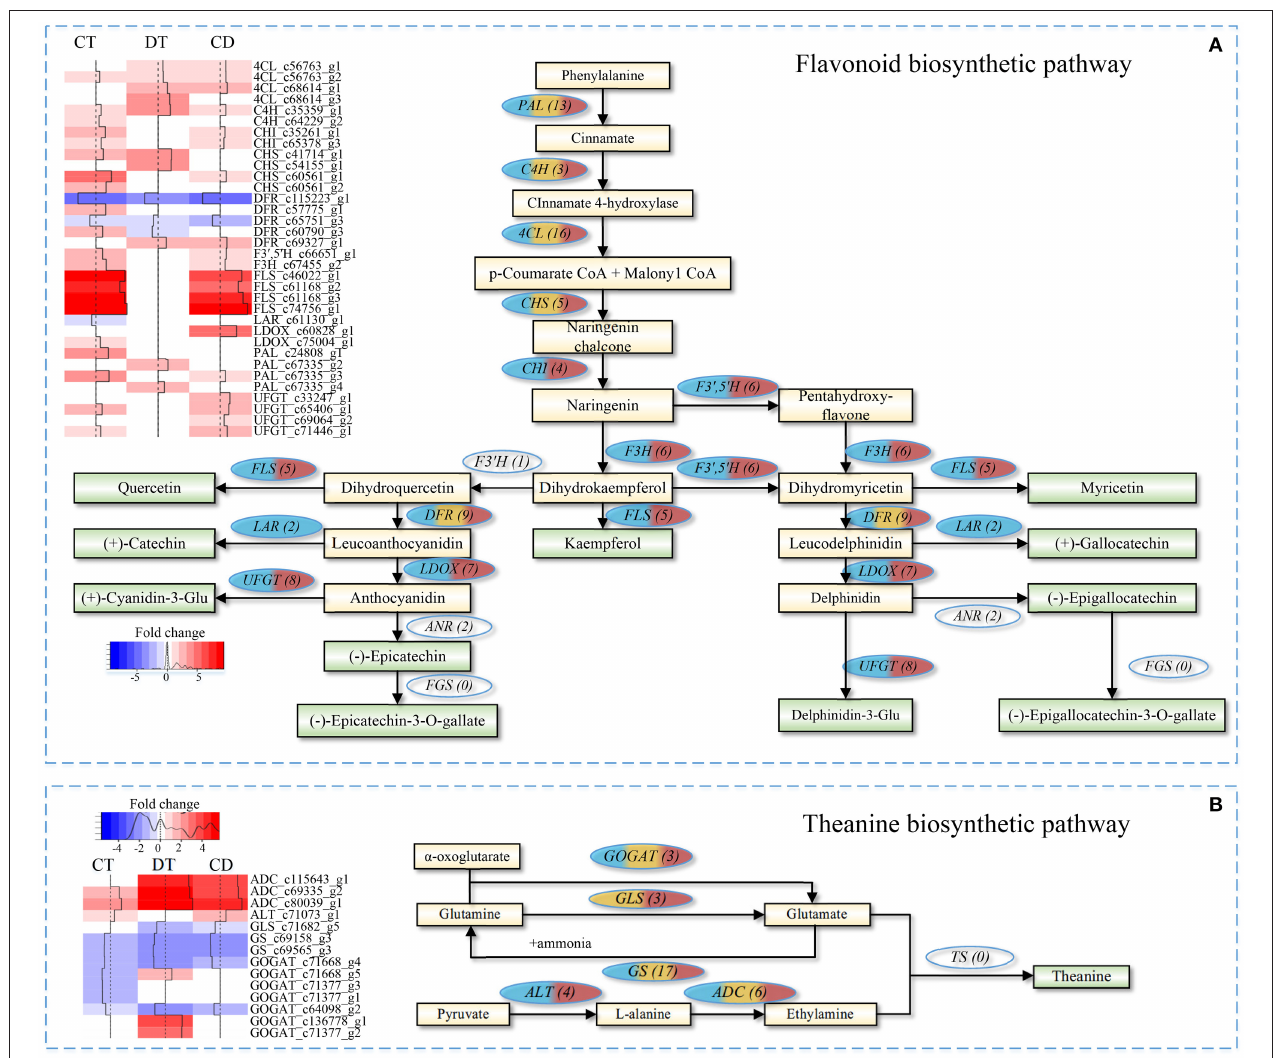
FIGURE 7 | Flavonoid and theanine biosynthetic pathway in C. sinensis under CT, DT, and CD. Heat maps on the left show fold change of the DEGs involved in (A) flavonoid biosynthetic pathway and (B) theanine biosynthetic pathway under CT, DT, and CD. The numbers in the brackets following each gene name indicate the number of corresponding unigenes identified in transcriptome. The color in the ellipses represents the gene was regulated under particular stress treatment (blue indicates CT; yellow indicates DT; red indicates CD). Full names of enzymatic genes are expanded in Supplementary Tables 10 , 13